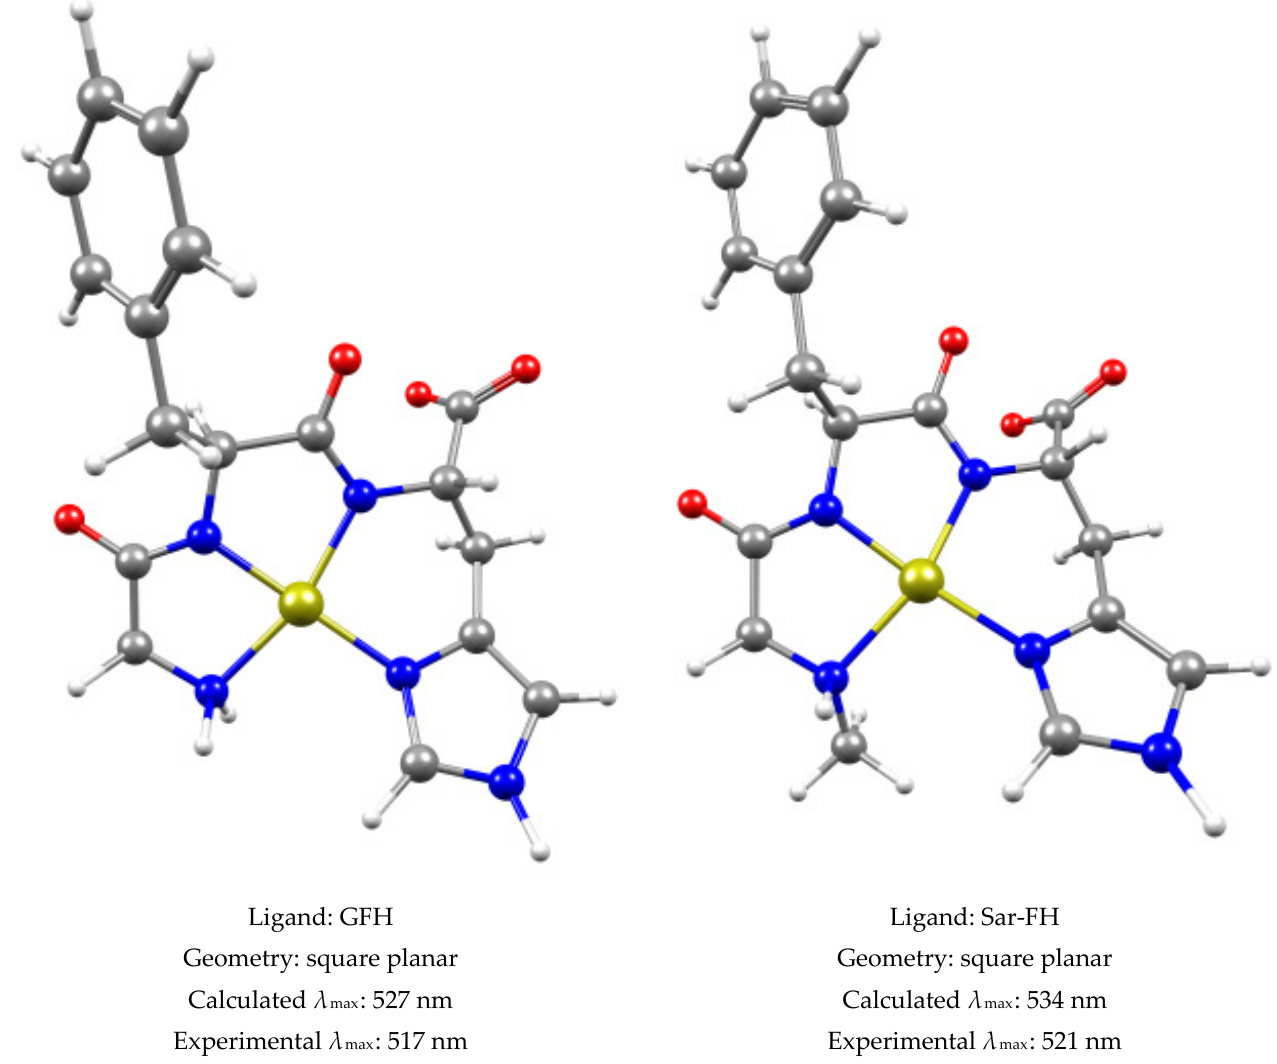
Figure 15. Visual representation of the proposed structures for the MLH –2 species of Cu-GLH, Cu- Sar-LH, Cu-GFH and Cu-Sar-FH, as well as their geometries, calculated λ max at B3LYP/6-31++G** in water and experimental λ max .